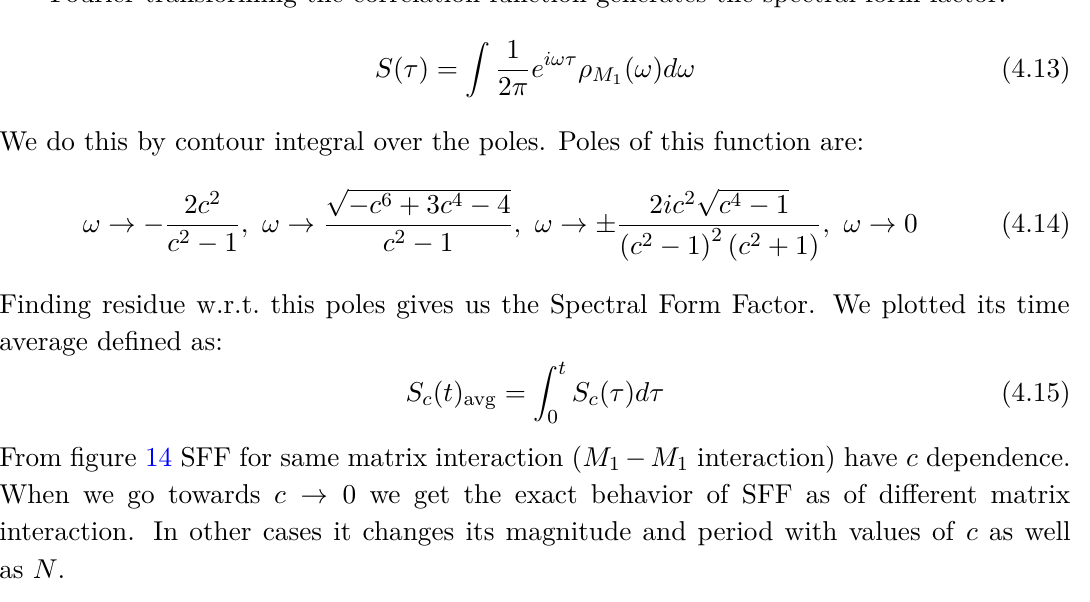
Figure 13 . Correlation function for same matrix interaction w.r.t. ω in Log scale using eq. (4.12).